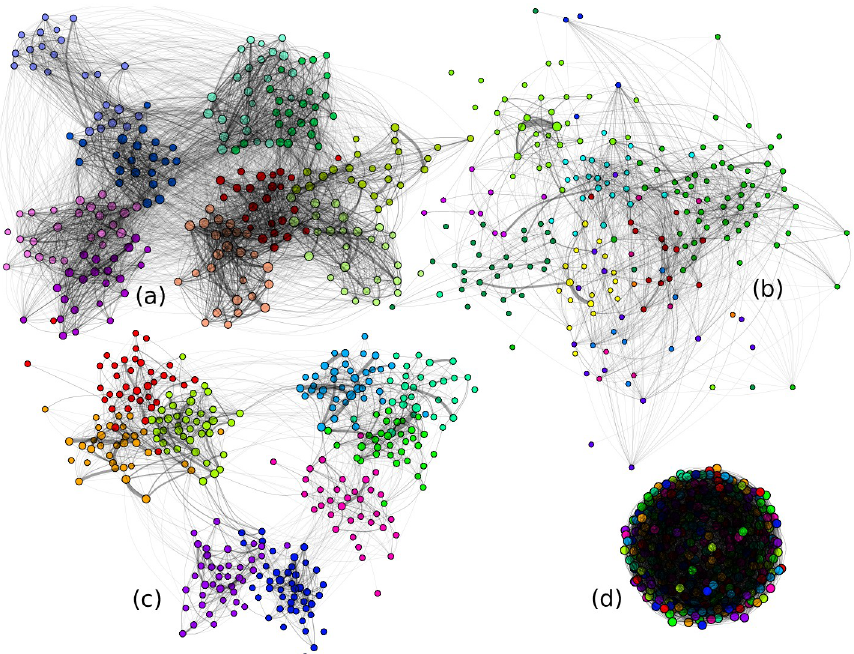
Fig 1. Contact graphs. (a-c) Three one-day contact networks in (a) a primary school with 242 students, (b) a workplace with 217 workers, (c) a high school with 327 students. Node colors correspond to known groups (classes or department). We see that the majority of contacts happen within groups. (d) A synthetic random graph with 9 groups selected randomly.